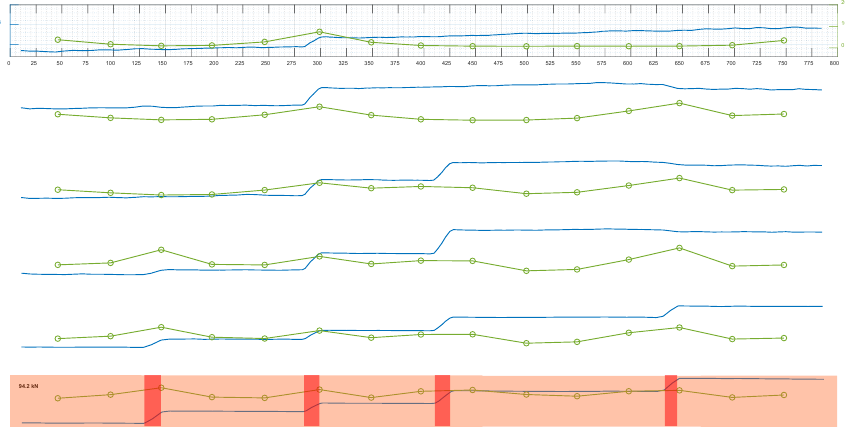
Figure 11. Surface displacement, debonding zones around detected cracks, and strain on embedded reinforcement under different loading levels.